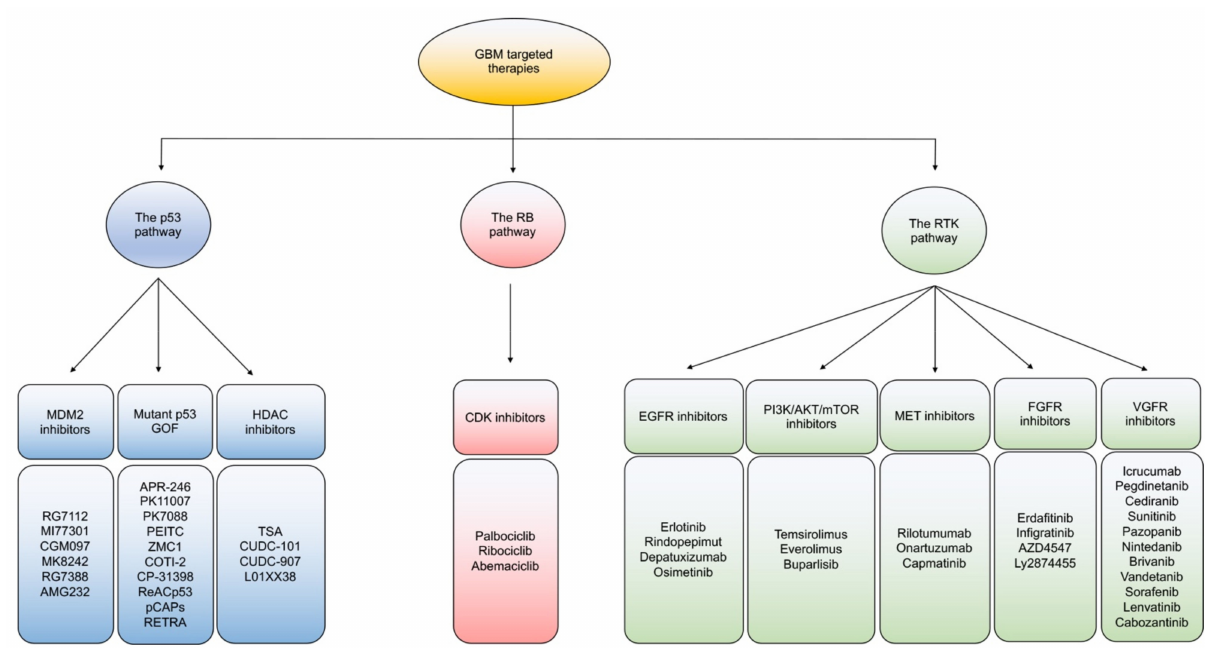
Figure 2. An overview of targeted therapies in GBM. Classification of current targeted therapies in GBM according to the three main signaling pathway alterations of the P53, Rb, and RTK pathways.